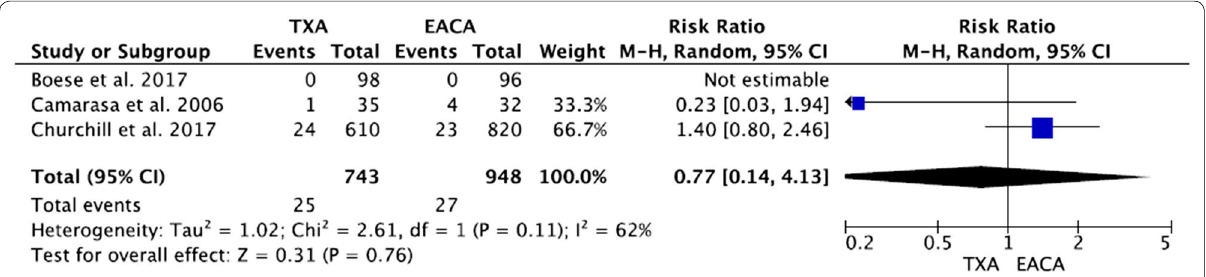
Fig. 3 Percentage of patients requiring transfusion